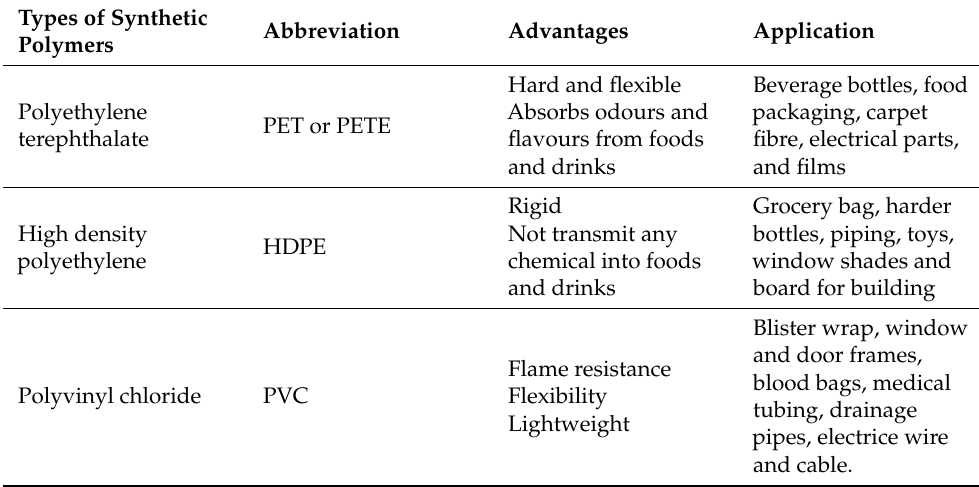
Table 2. Summary of commonly used synthetic polymer and their application